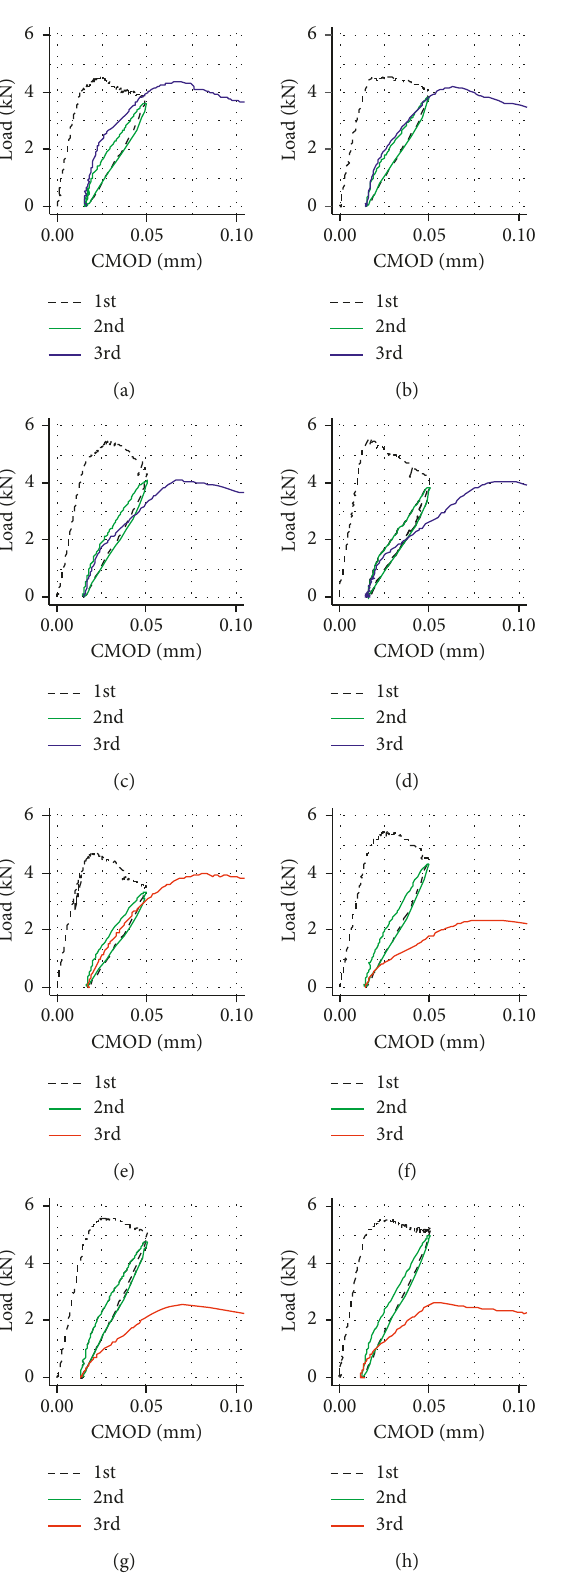
Figure 6: Typical load-CMOD curves of PVA concrete: (a) PVA- 7–28W, (b) PVA-28–49-W, (c) PVA-49–70-W, (d) PVA-91–112- W, (e) PVA-7–28-A, (f) PVA-28–49-A, (g) PVA-49–70-A, and (h)